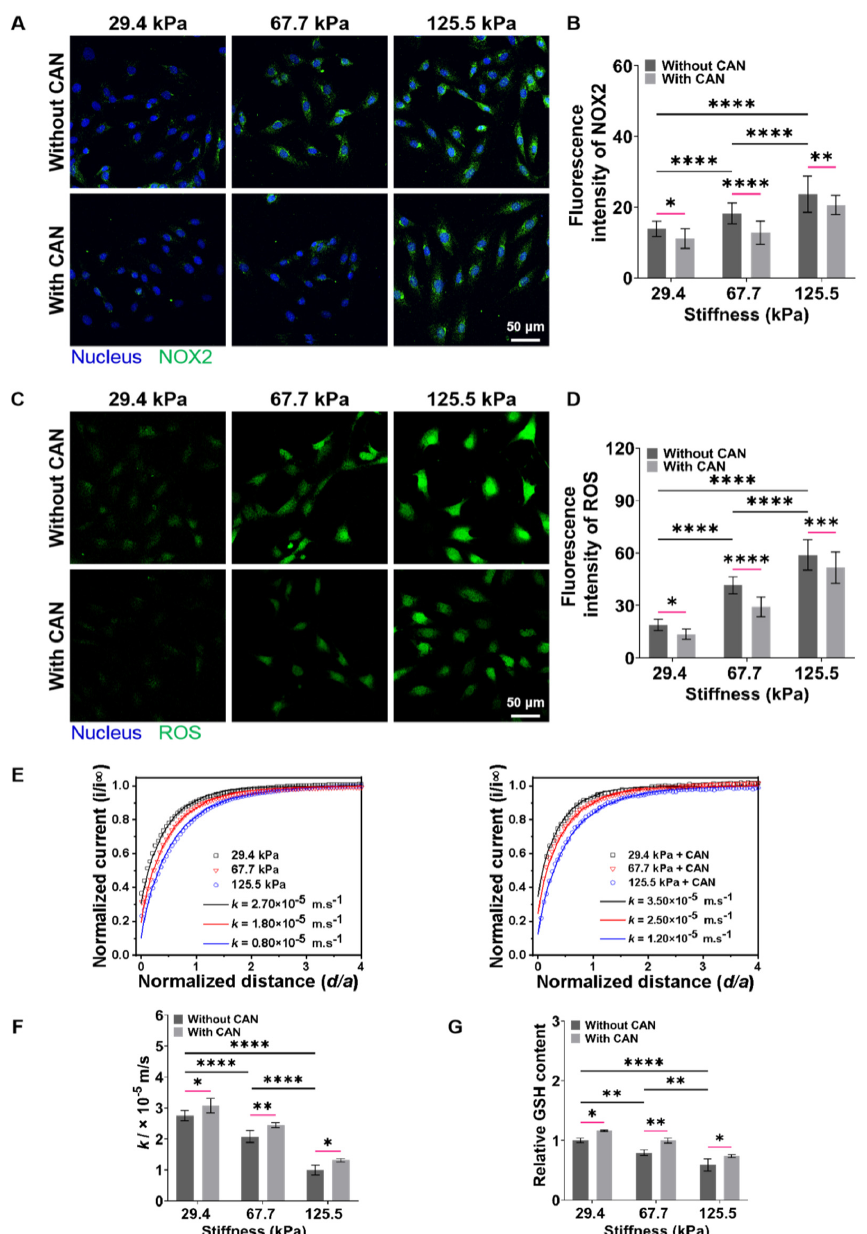
Figure 7. Characterization results of NOX2, ROS, and GSH levels produced from CFs on PA gels with a stiffness of 29.4, 67.7, and 125.5 kPa. ( A ) NOX2 fluorescence images of CFs on PA gels with different stiffness without and with CAN treatment. ( B ) Statistical histogram of NOX2 fluorescence intensities expressed by CFs ( n > 3). ( C ) ROS fluorescence images of CFs on PA gels with different stiffness without and with CAN treatment. ( D ) Statistical histogram of ROS fluorescence intensities expressed by CFs ( n > 3). ( E ) SECM approach curves to CFs on PA gels with different stiffness without and with CAN treatment. ( n = 6). ( F ) Statistical histogram of k values of CFs on PA gels with different stiffness without and with CAN treatment ( n = 6). ( G ) Statistical histogram of relative content of GSH in CFs on PA gels with different stiffness without and with CAN treatment characterized by GSH assay kit ( n = 3). Data are shown as means ± SEM. * p < 0.05, ** p < 0.01, *** p < 0.001, and **** p < 0.0001 determined by two-way ANOVA.